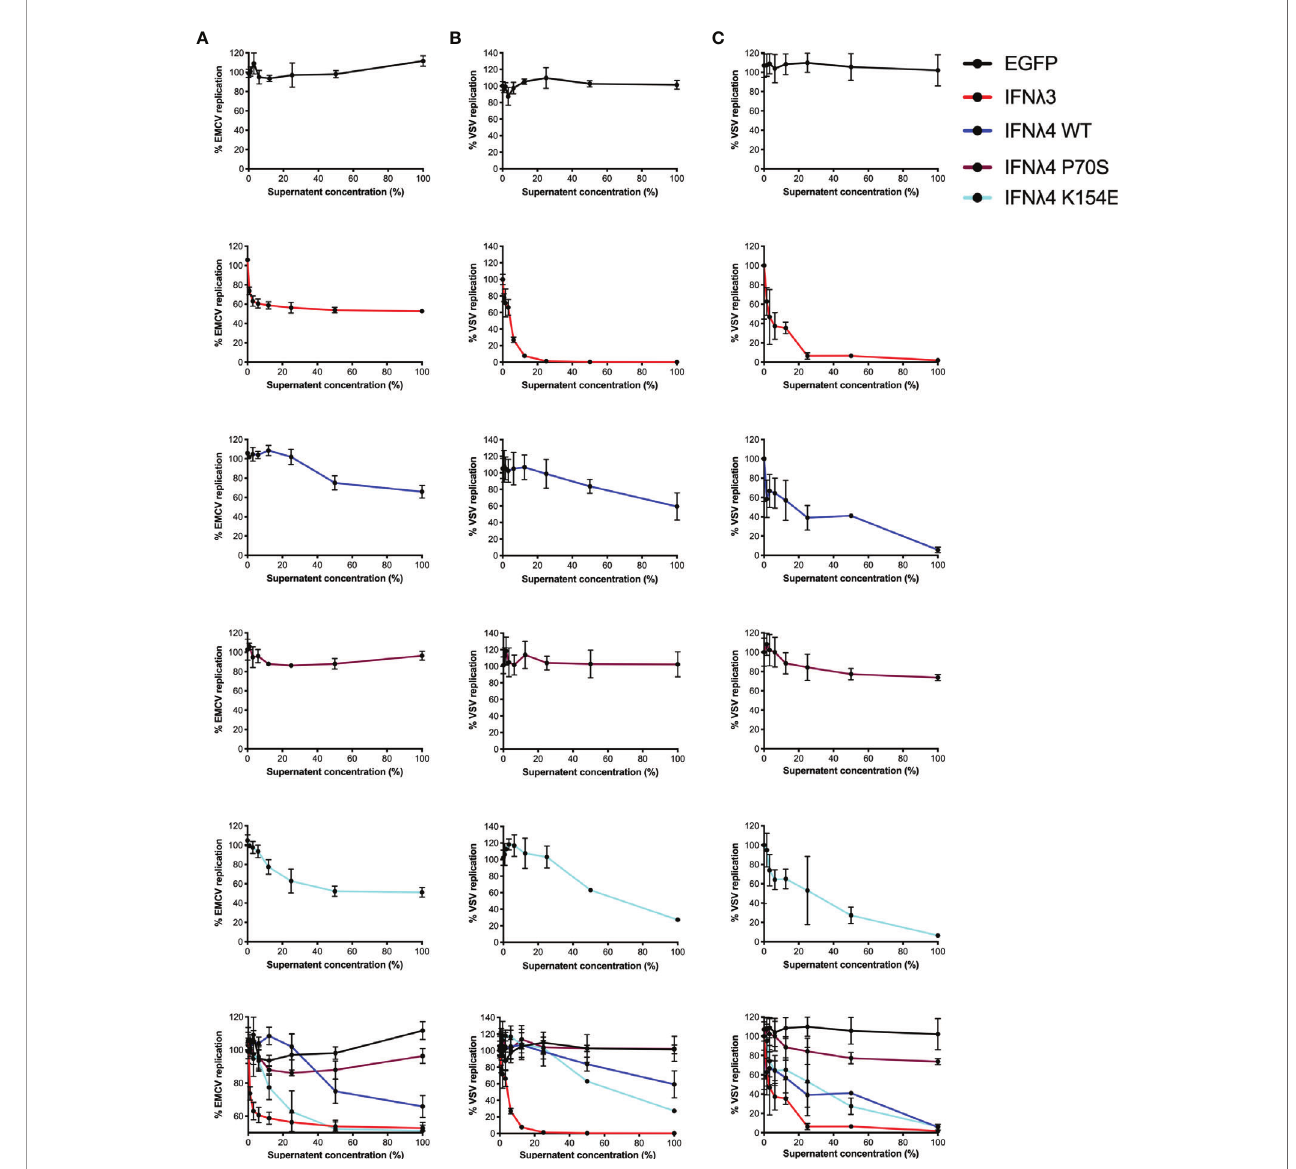
FIGURE 3 | Antiviral activity against EMCV or VSV of IFN l s on HepaRG and T84 cells. HepaRG (A, B) or T84 (C) cells were stimulated with different concentrations of supernatant containing the panel of IFN l s [IFN l 3-HiBiT (red); IFN l 4-HiBiT: WT (blue), P70S (purple), and K154E (cyan)] before being challenged with EMCV (A) or VSV (B, C) and antiviral activity calculated, shown here as percentage of viral replication at each dilution compared to mock (EGFP conditioned media treated) treated controls. Error bars represent the mean ± SEM from two to three biological